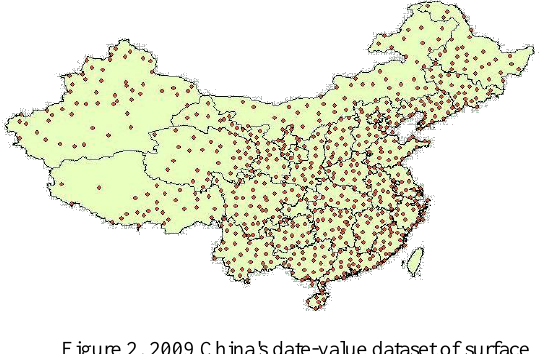
Figure 2. 2009 China's date-value dataset of surface